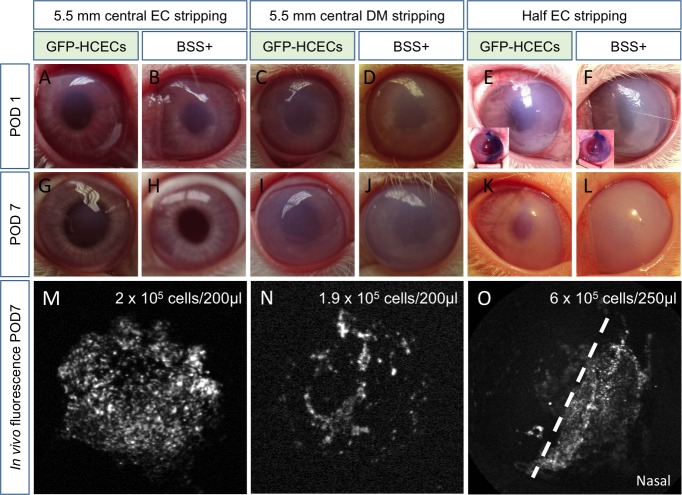
Regenerative ability of magnetic HCECs in different rabbit models of corneal edema. Three different injury models as labeled induced corneal edema in all eyes at POD 1 (A–F); the edema was less severe when DM was left intact (A, B). (E, F) Insets are example images taken during surgery of Trypan blue staining the injured corneal endothelium. By POD 7, the animals that underwent EC stripping had more transparent corneas (G, H) than the rest of the animals (I, J). Eyes that were injected with magnetic GFP-HCECs (I, K) were less cloudy than those injected with equal volume of BSS+ (J, L). Using an OCT fluorescence angiography module, GFP signal could be detected in live animals at POD 7 (M–O). A denser, brighter signal was observed in EC-stripped eyes (M, O) compared to DM-stripped eyes (N).